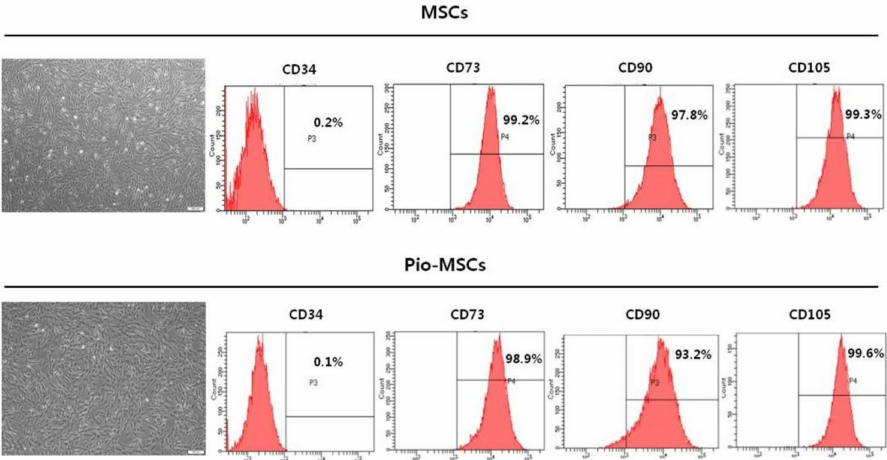
Figure 1. Comparison of the morphology and cell surface marker profile between human Wharton’s jelly mesenchymal stem cells (MSCs) and pioglitazone-pretreated MSCs (Pio-MSCs). Both cell types showed a typical MSC morphology with a spindle- or fibroblast-like appearance. Flow cytometry indicated that both types were positive for the known MSC markers CD73, CD90, and CD105, but negative for